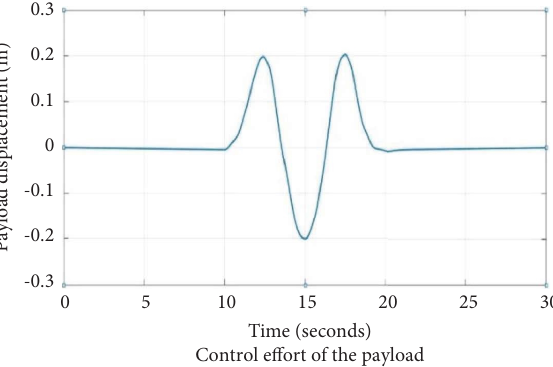
Figure 15: System response with the fourth input signal using hybrid